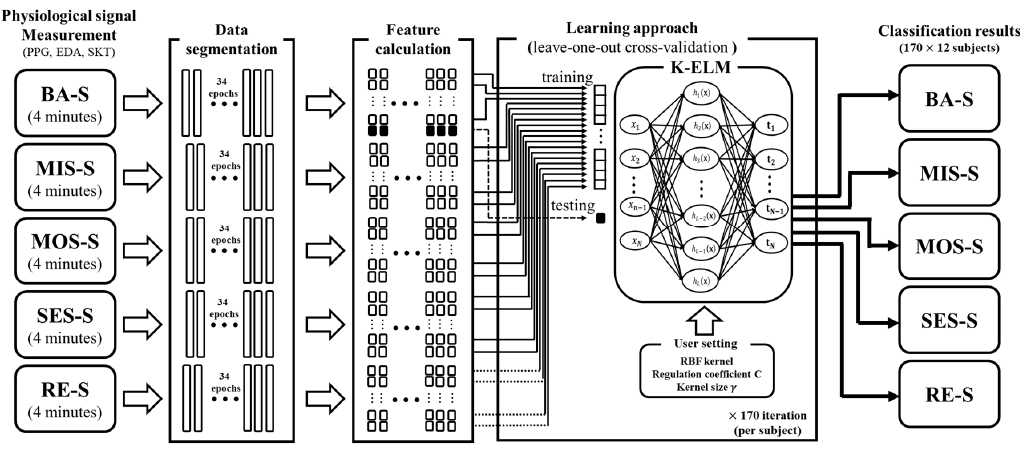
Figure 7. Overall feature extraction and classification process. The data-segmentation and feature-calculation steps are applied to the measured physiological signals (PPG, EDA, and SKT). The white and black boxes in the feature-calculation step represent the training and test sets, respectively.